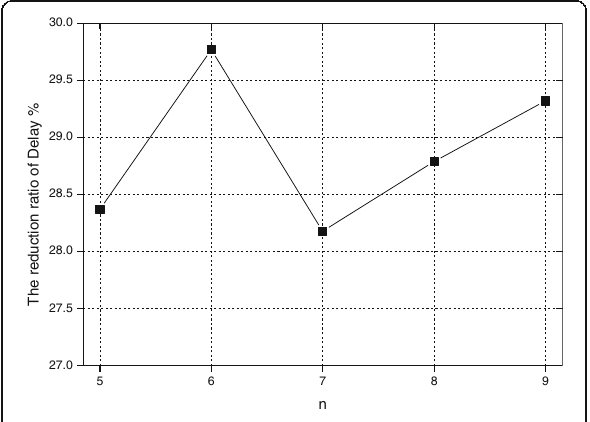
Fig. 33 The delay reduction of UDCNP vs ODCNP (MQAM) According to Eq. (22), we can calculate the distance between the nodes as in Table 3. Figure 18 is the maximum energy consumption at linear network with n = 6. It can be seen that when UDNP uses the optimal duty cycle, the maximum en- ergy consumption is reduced by 2.80127 dB over that of EDNP. Figure 19 is the optimal duty cycle of the network at the MPSK modulation technique. Figure 20 is the maximum energy consumption at the optimal duty cycle of UDNP and EDNP. From Fig. 21, it can be seen the UDNP scheme is reducing the maximum energy consumption by more than 44% over the EDNP scheme. n = 6 linear network under the MPSK modulation tech- nique. Figure 23 is the delay of each node in the network under the MPSK modulation technique. Similarly, the maximum delay for the UDCNP scheme is reduced by 2.37812 compared to that for the ODCNP scheme.